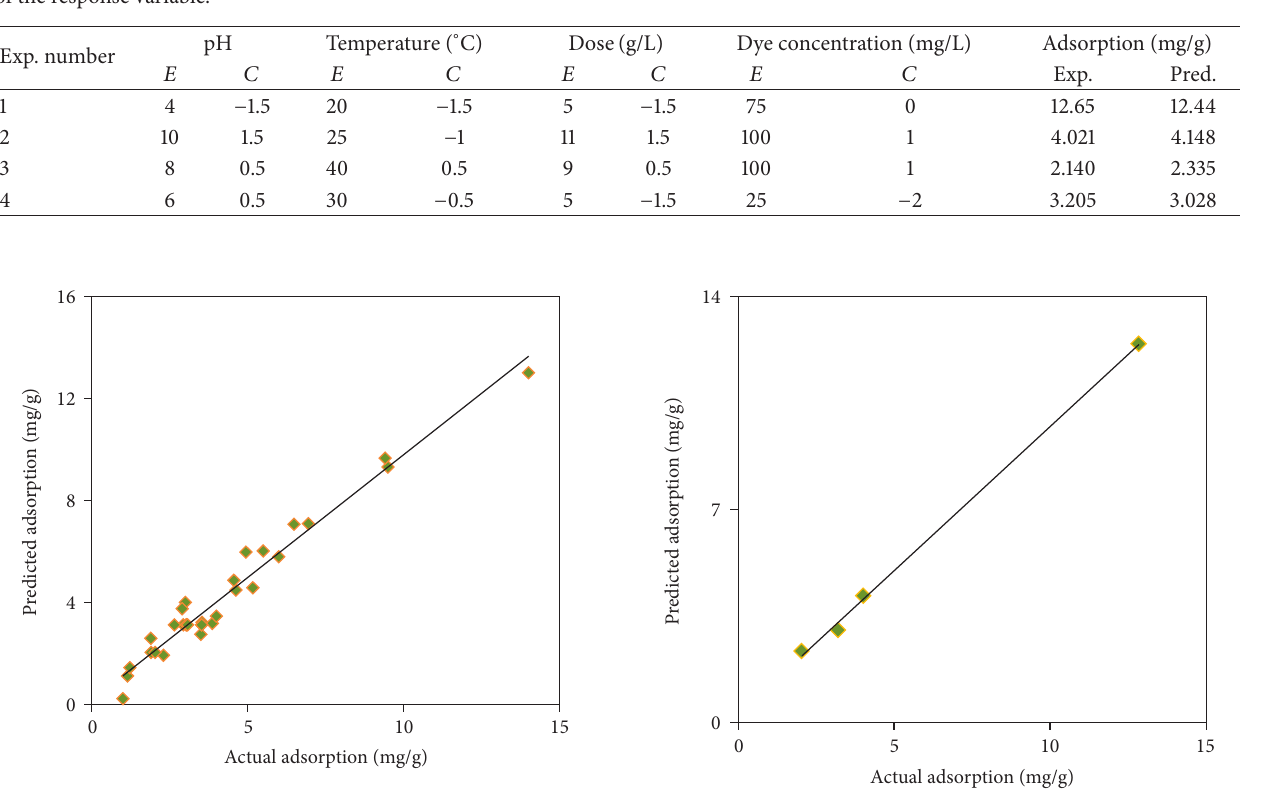
Table 6: The experiment (𝐸) and the coded (𝐶) values of the independent process variables in the validation model and corresponding values of the response variable.